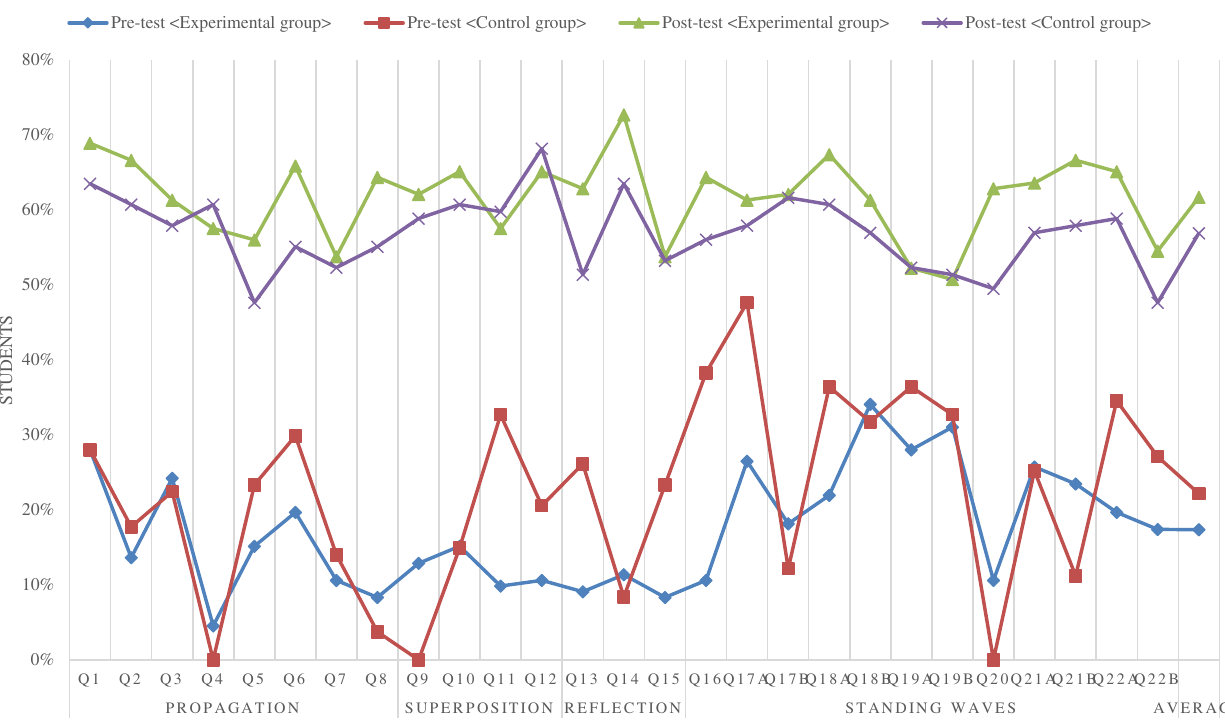
FIG. 5. A display of MWCS questions revealing students ’ difficulties after teaching interventions among the groups that were given both pretest and